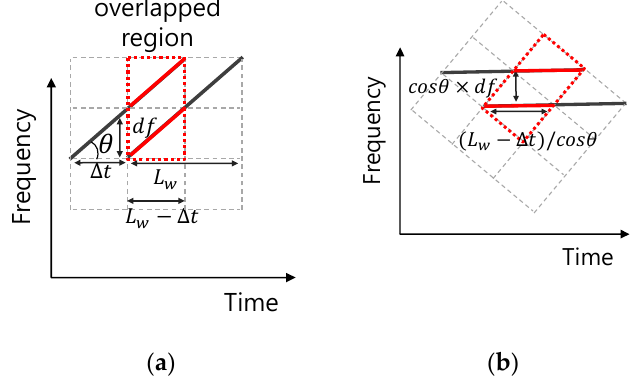
Figure 3. TFSK modulation whistle; ( a ) Normal, ( b ) Rotation by θ